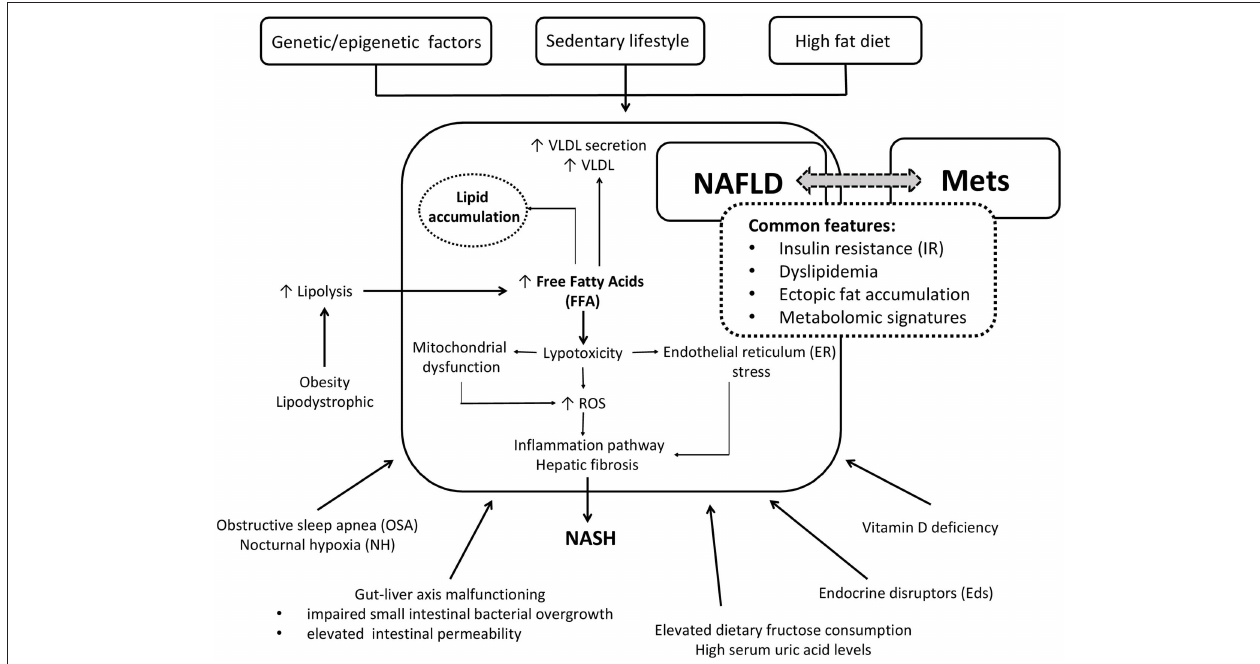
FIGURE 1 | Simplified cartoon of the main pathophysiological mechanisms linking NAFLD and Mets in